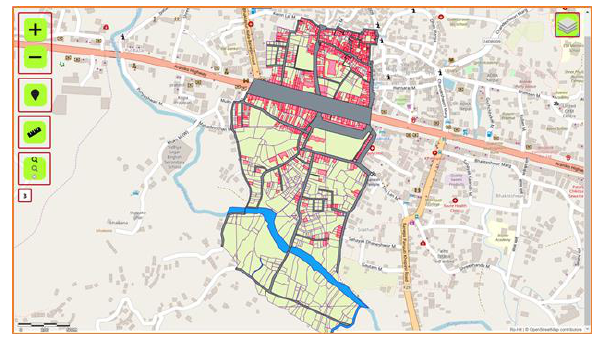
Figure 3. Admin View of the webpage.